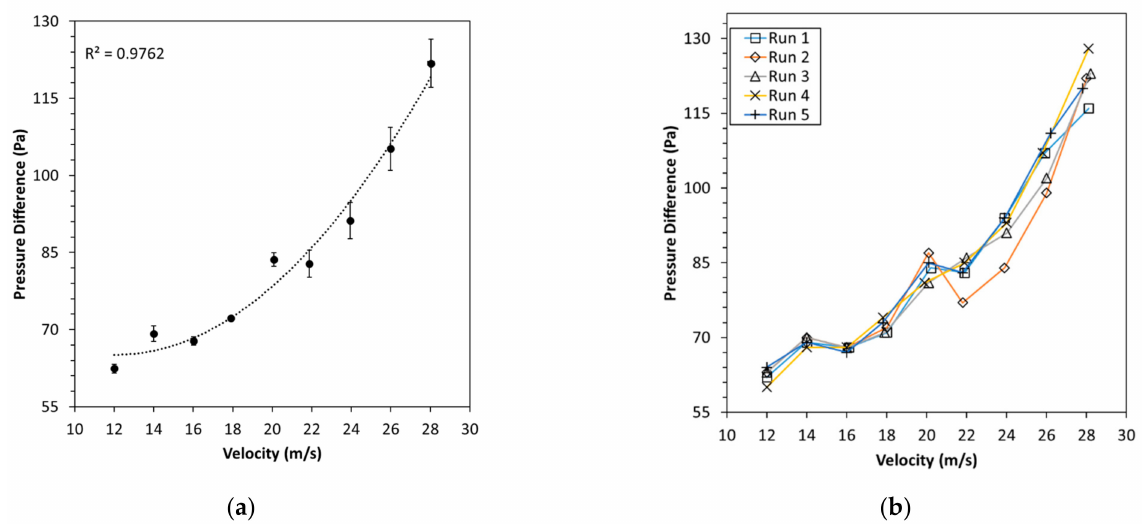
Figure 7. Experimental results for smooth NACA/elliptical profile; ( a ) average of 5 runs and ( b ) 5 individual